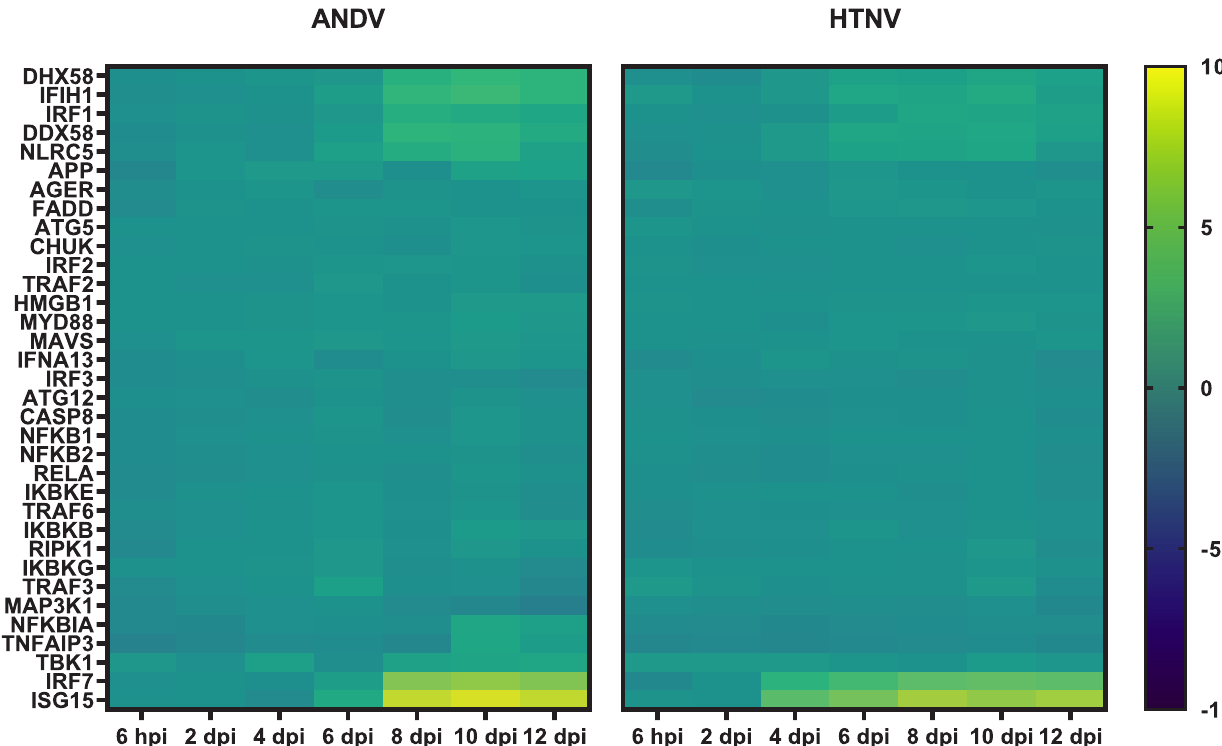
Fig 4. Interferon Sensing and Induction in Hantavirus Infected Hamsters. Genes associated with interferon sensing and induction are displayed as a heat map with hierarchical clustering and intensity of the colors corresponding to the magnitude of fold change over the baseline.